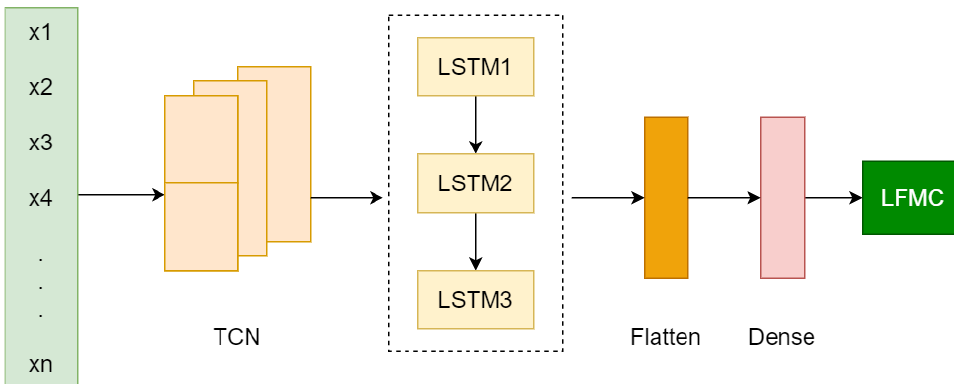
Figure 2. Structure of TCN-LSTM model.